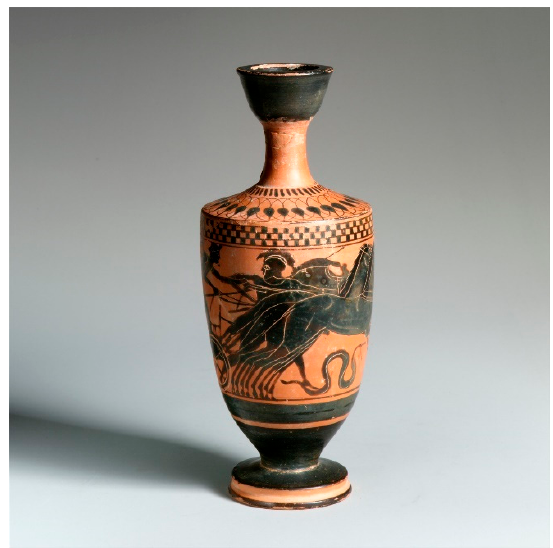
Figure 8. Dragging of Hektor’s body (MMA acc. no. 25.70.2); black-figure lekythos; attr. to the Diosphos Painter; Attica; ca. 510–490 BCE . [Image courtesy of the open-access program of the Metropolitan Museum of Art, New York].